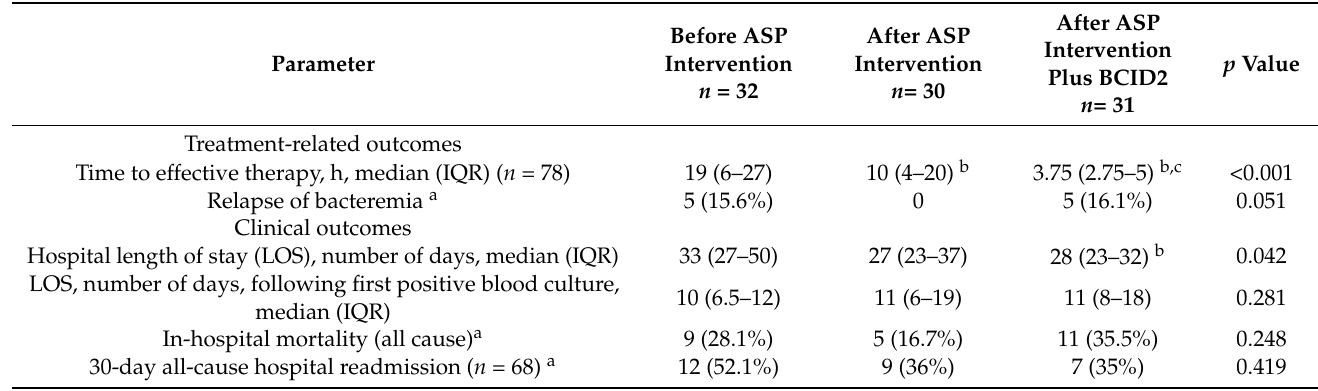
Table 6. Treatment and clinical